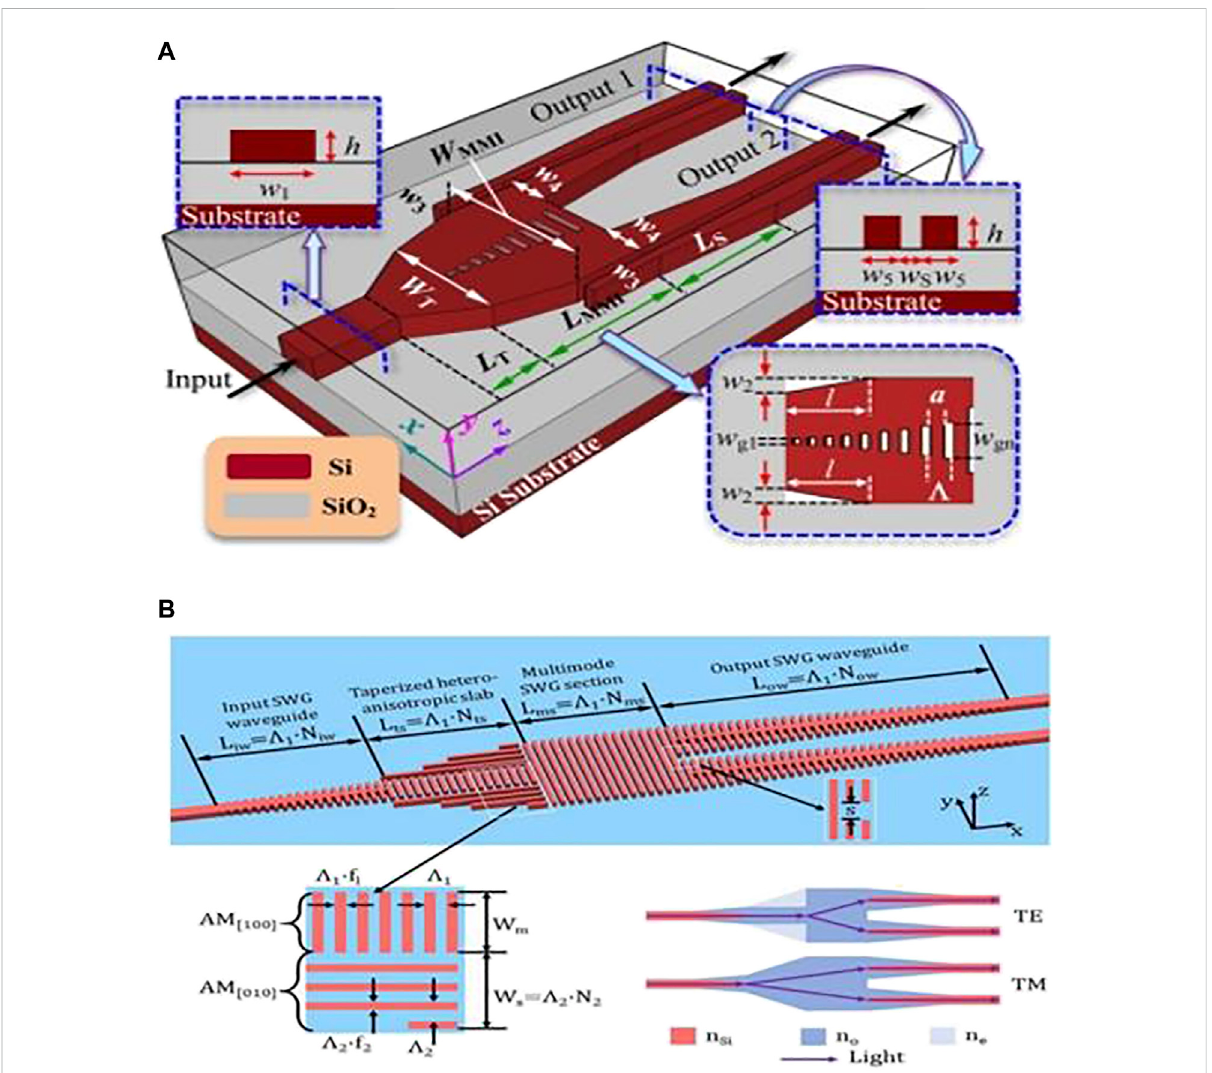
FIGURE 3 MMIcouplingstructureforpowerbeamsplitting. (A)